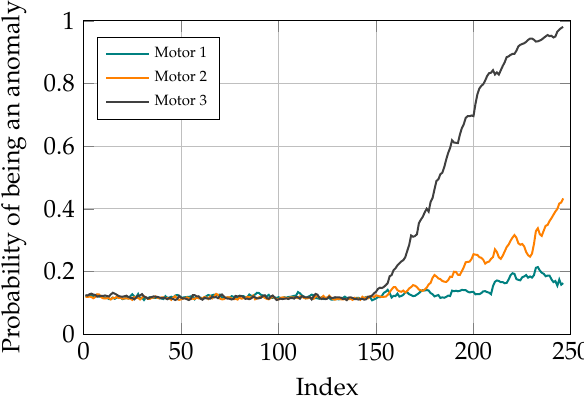
Figure 15. Simulation results with distortion added to motor 3.